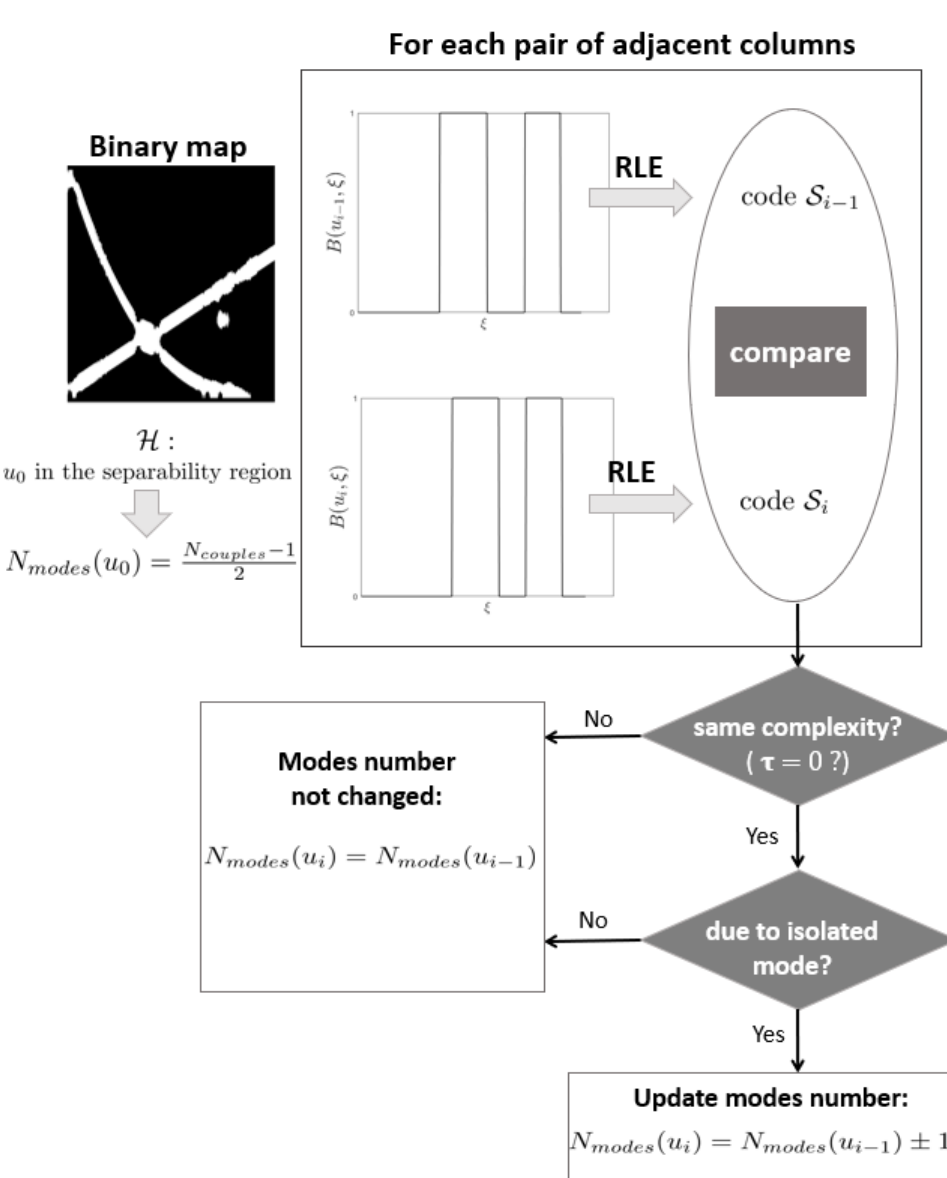
Figure 10. Flow-chart of the algorithm. Step 2: Binary map encoding by RLE and modes